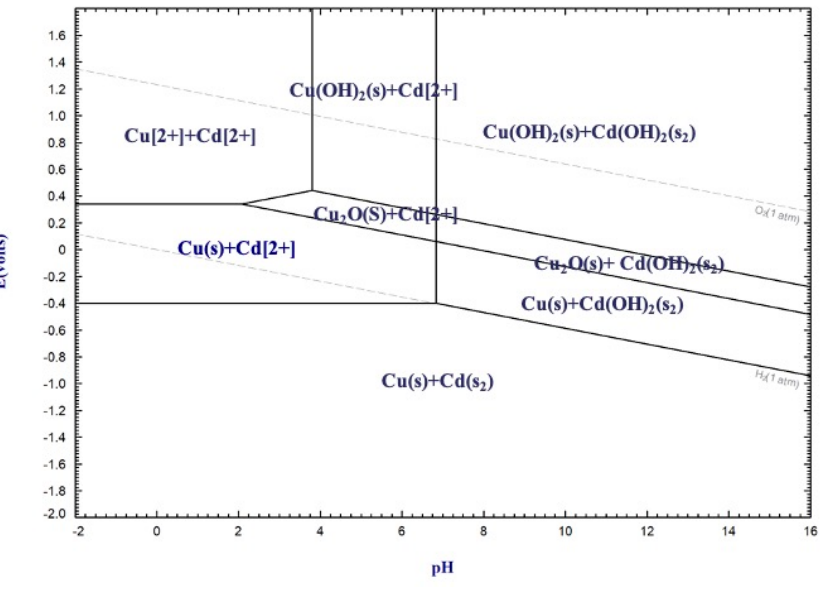
Figure 3. The E–pH diagram of the Cu-Cd-H 2 O system